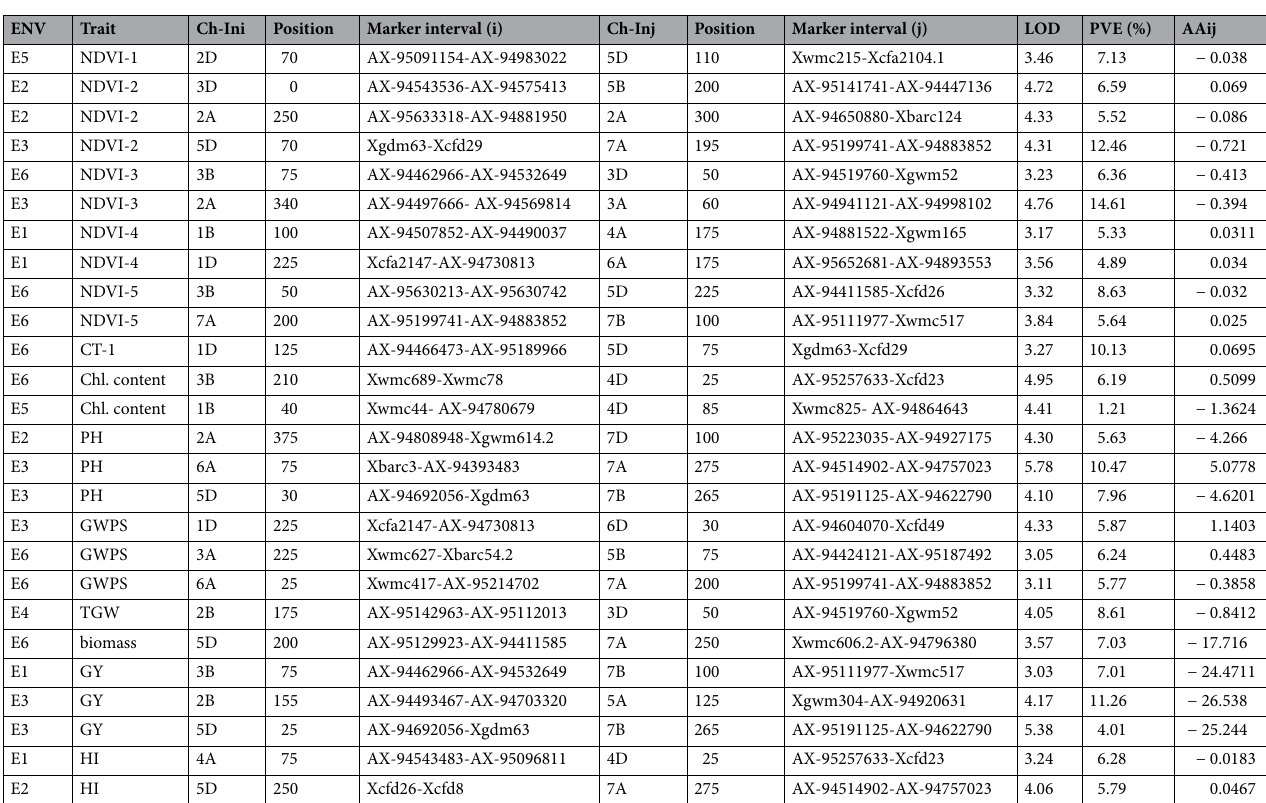
Table 4. QTL × QTL epistatic interactions identified for various physiological and yield component traits. 1) AAij, epistatic effects), Position of QTL located on chromosome: as cM distance from the top of each map. LOD, A LOD threshold of 3 was used for declaration of QTL, PVE (%), Phenotypic variance explained by QTL. Location code; E1-Delhi rainfed (2016–17), E2-Delhi irrigated (2016–2017), E3-Indore restricted irrigation (2016–2017), E4-Powarkheda rainfed (2016–2017), E5-Delhi rainfed (2017–2018), E6-Delhi irrigated (2017– 2018) and E7-Indore restricted irrigation